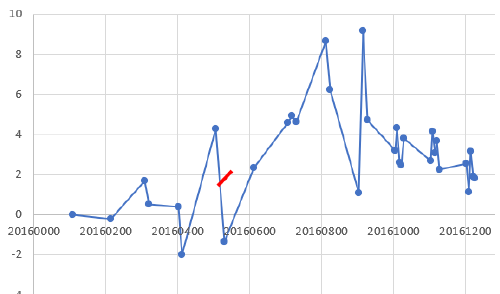
Figure 8. Surface displacement in mm, where there is the collapsed building, the redline indicates the date of collapsing.